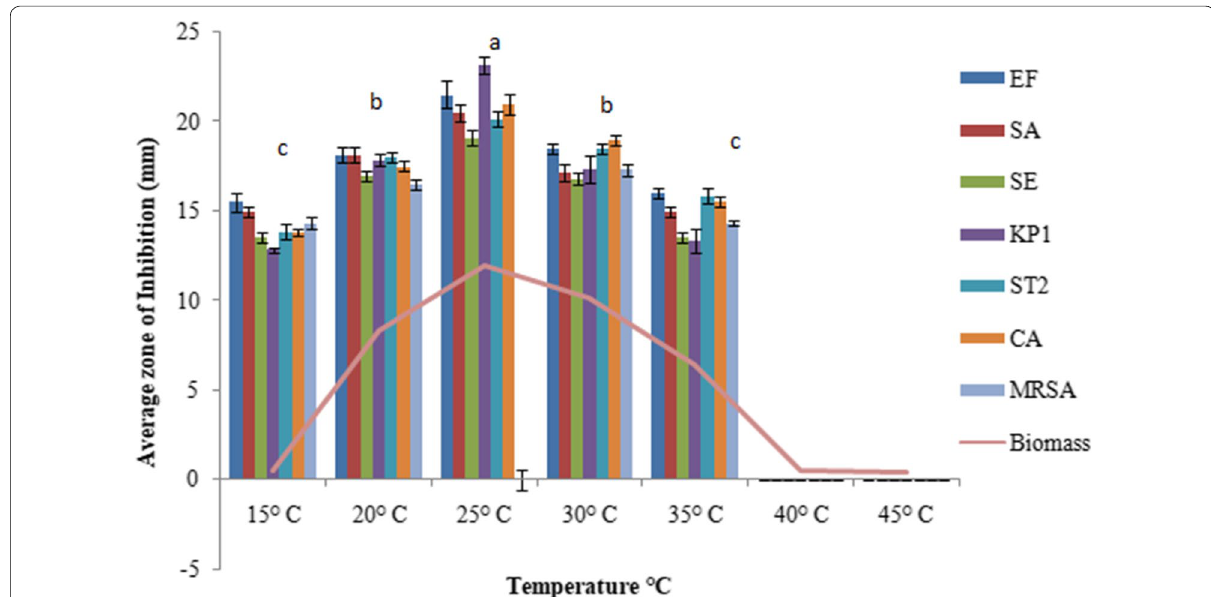
Fig. 4 Effect of temperature on antimicrobial activity of C. globosum. EF, Enterococcus faecalis; SA, Staphylococcus aureus ; SE, Staphylococcus epidermidis ; KP1, Klebsiella pneumoniae 1; ST2, Salmonella typhimurium 2; CA, Candida albicans MRSA, Methicillin-resistant Staphylococcus aureus . *Values are given as mean SE. Different letters (a to c) between the columns are significantly different (post hoc tukey Test, p ±